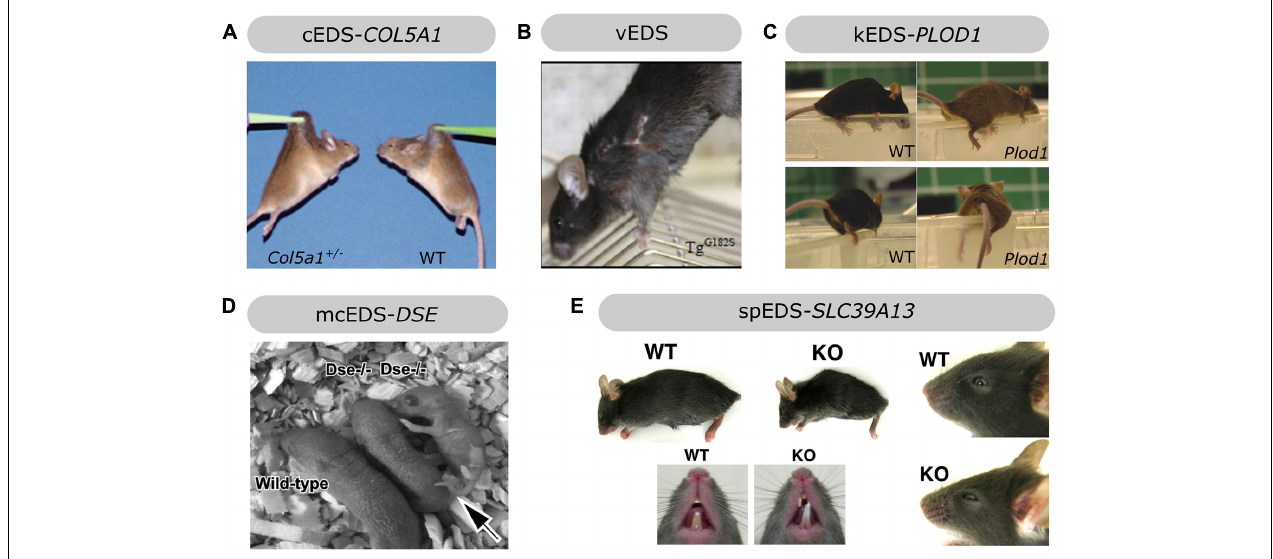
FIGURE 4 | Overview of the phenotypic findings in some mouse models of EDS. (A) Col5a1 + / − mouse model of cEDS. Images adapted from Wenstrup et al. (2006). (B) Col3a1 Tg − G 182 S mouse model of vEDS. Image adapted from D’hondt et al. (2018). (C) Plod1 − / − mouse model of kEDS- PLOD1 . Images adapted from Takaluoma et al. (2007). (D) Dse − / − mouse model of mcEDS- DSE . Image adapted from Maccarana et al. (2009). (E) Slc39A13 -KO mouse model of spEDS- SLC39A13 . Images adapted from Fukada et al. (2008). Images depicted in (A,C,D,E) were used under the Creative Commons License and image B with license number 5090710991420.